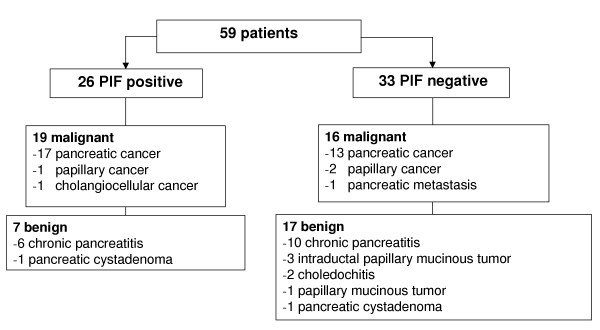
Diagnoses in PIF positive and PIF negative patients